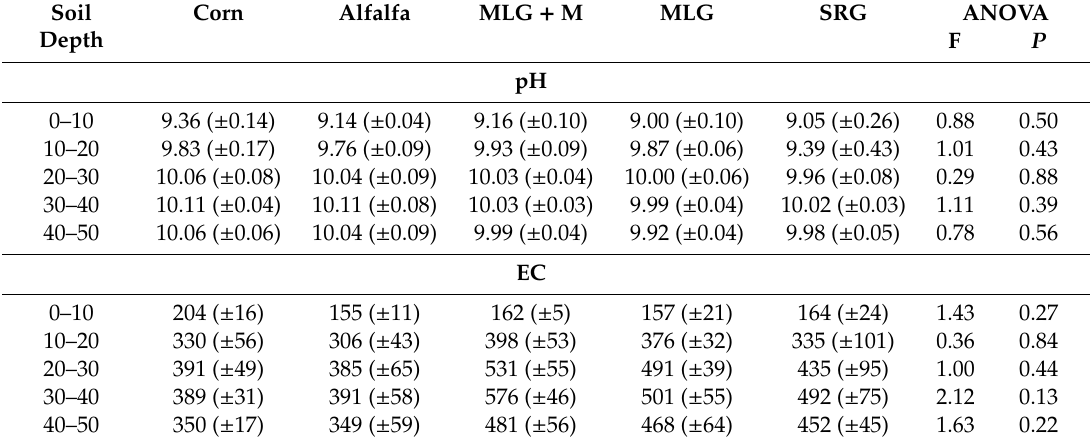
Table 1. Mean values ( ± SE) of soil pH and electrical conductivity (EC) under di ff erent land uses. Soil Corn Depth